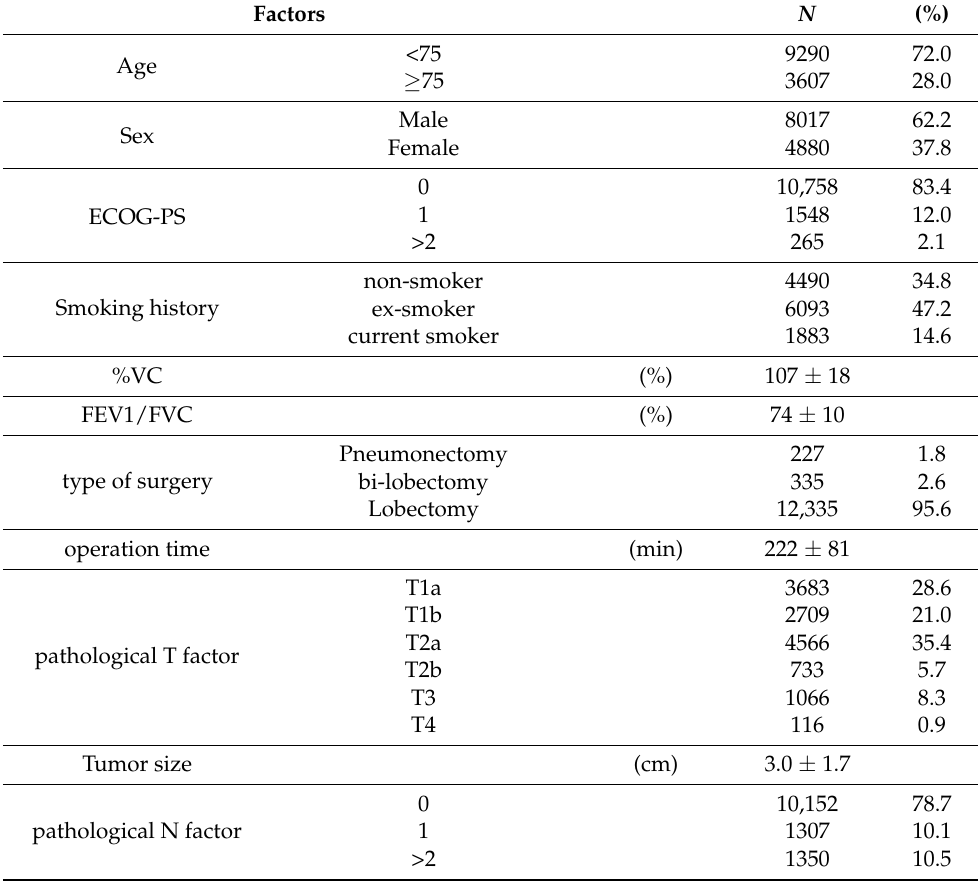
Table 1. Patients’